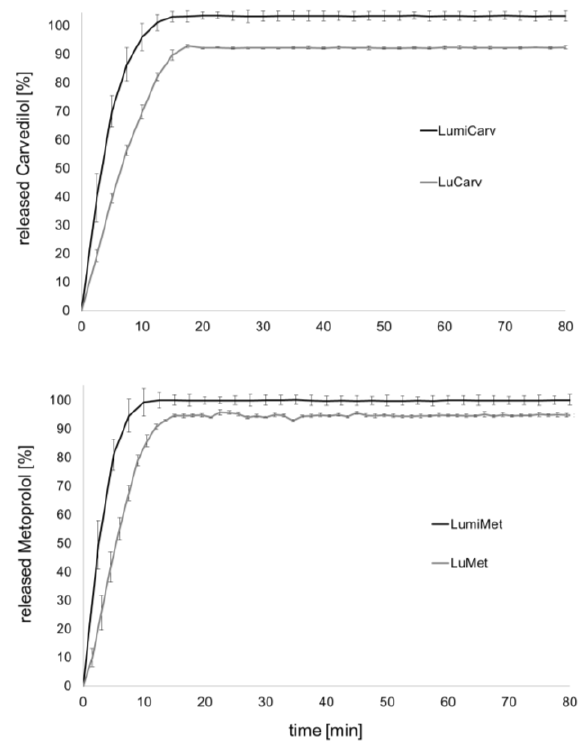
Figure 7. Dissolution profiles of divided doses from melt-extrudates, basket apparatus, 37 °C, 50 rpm, mean ± s, n = 6, 900 mL ( a ) carvedilol, 0.1 N HCl; ( b ) metoprolol tartrate, purified